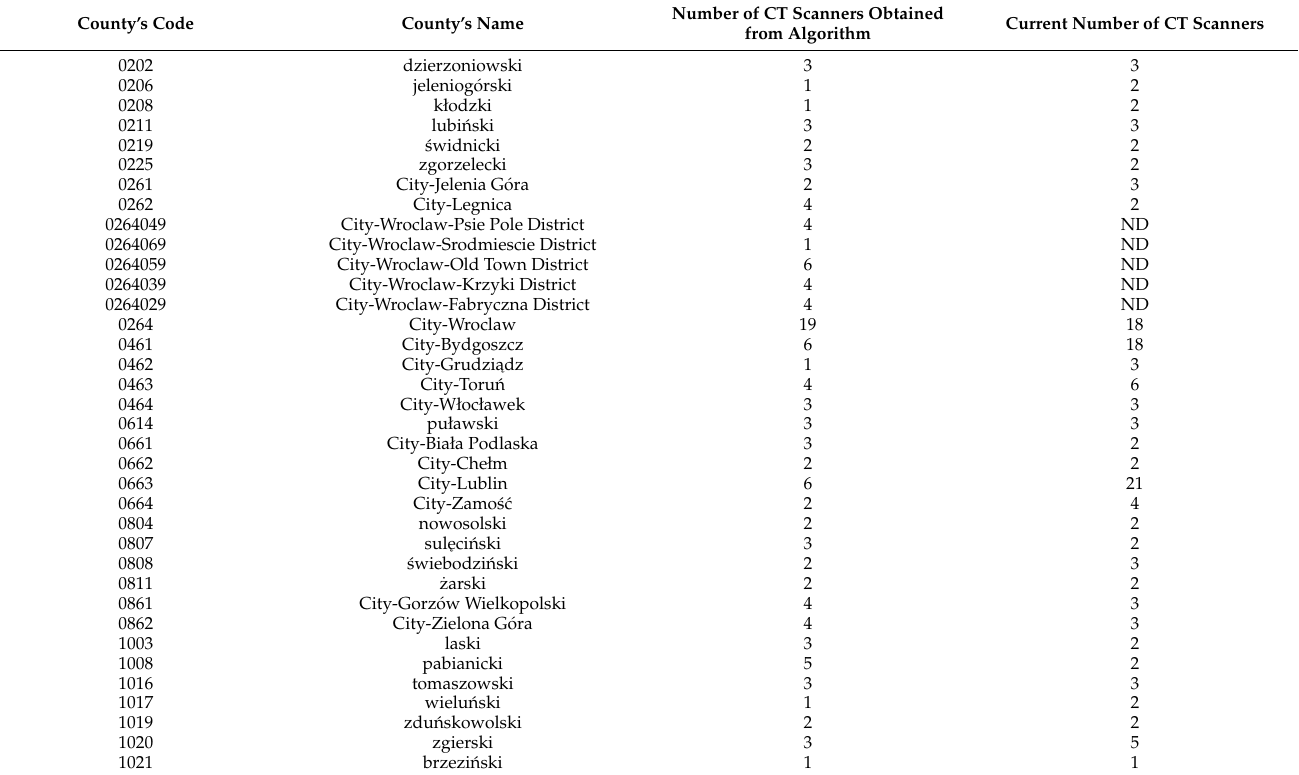
Table 2. Number of CT scanners determined by the EA model (best chromosome) per each county